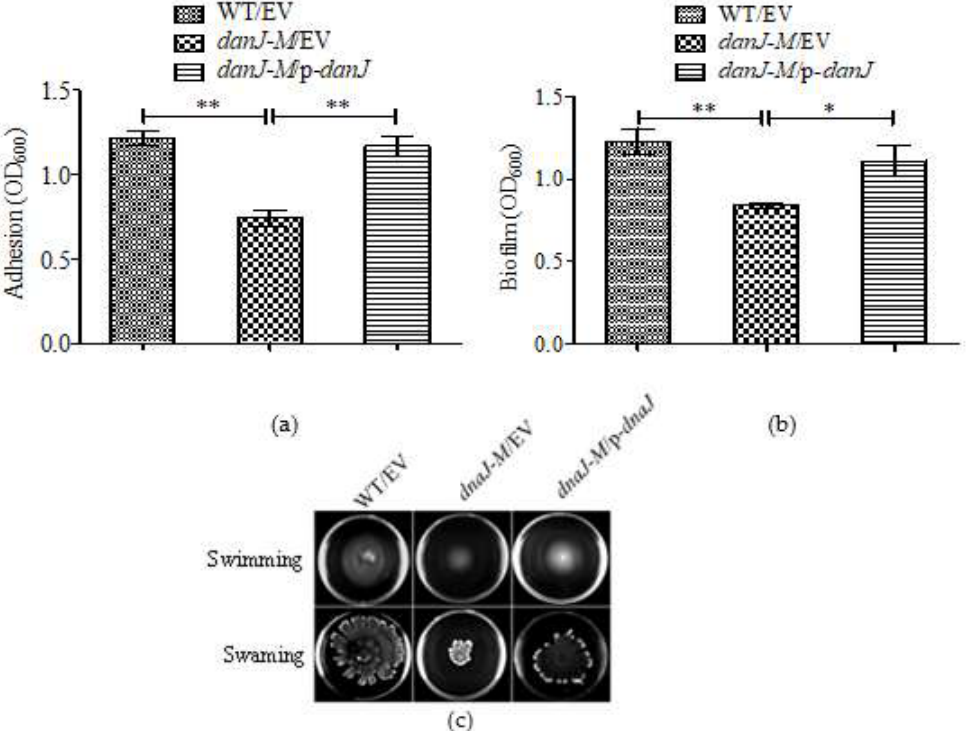
Figure 3. Reduced initial adhesion, final biofilm formation, and motility in dnaJ-M . ( a ) The ability of adhesion of wild type PAO1, dnaJ-M , and the complementation strains; ( b ) the production of biofilms in these strains; ( c ) the changed swarming and swimming motilities in dnaJ-M . The images were captured using a LAS-3000 imager system. EV: Empty vector control. p- dnaJ : dnaJ complementation construct. A two-tailed unpaired t -test was performed using GraphPad software version 5.0 (* p < 0.05; ** p < 0.01). NS: Not Significant.